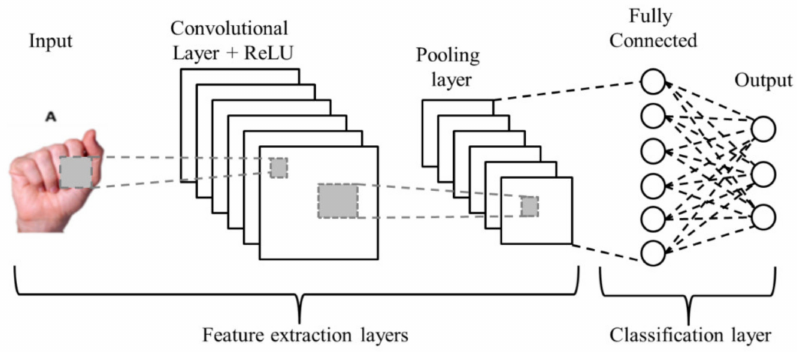
Figure 1. The minimal architecture of a